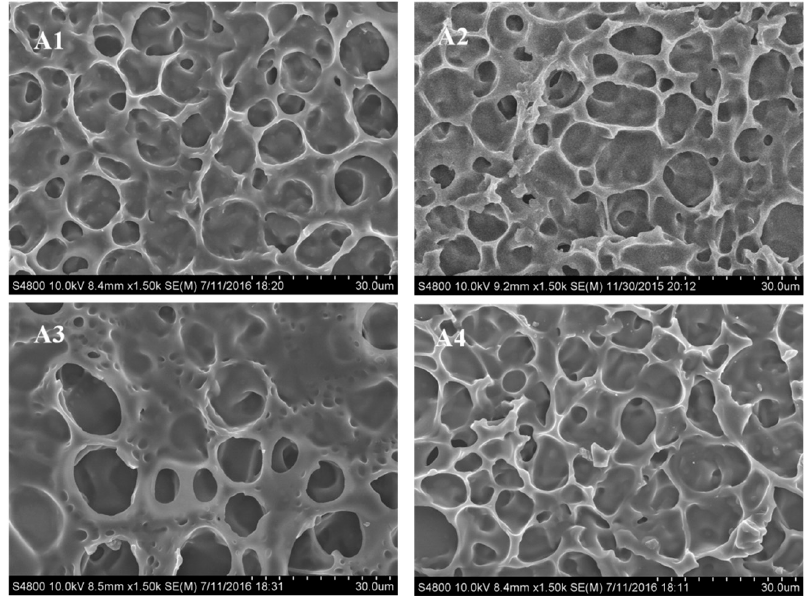
Figure 1. Scanning electron micrographs (SEM) of the polymer networks of the samples A1–A4.